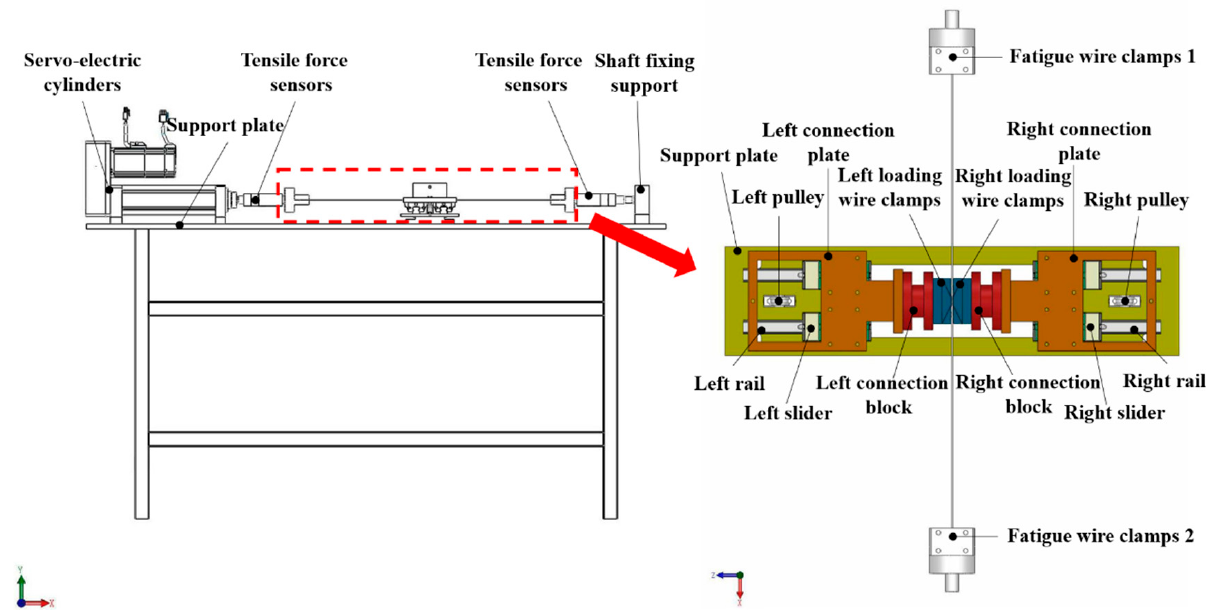
Figure 1. Structural diagram of the test